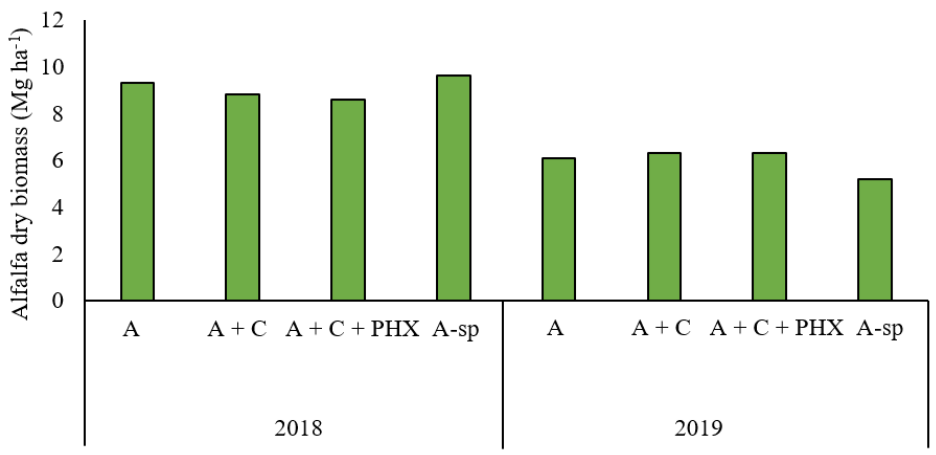
Figure 3. Seasonal alfalfa dry biomass yield for second year of production in 2018 and 2019 at Boone, IA, USA, for (A) alfalfa; (A + C) alfalfa + corn; (A + C + PHX) alfalfa + corn + prohexadione calcium; (A-sp) spring-planted alfalfa. Treatments were the same within the year at the p ≤ 0.05 probability level.